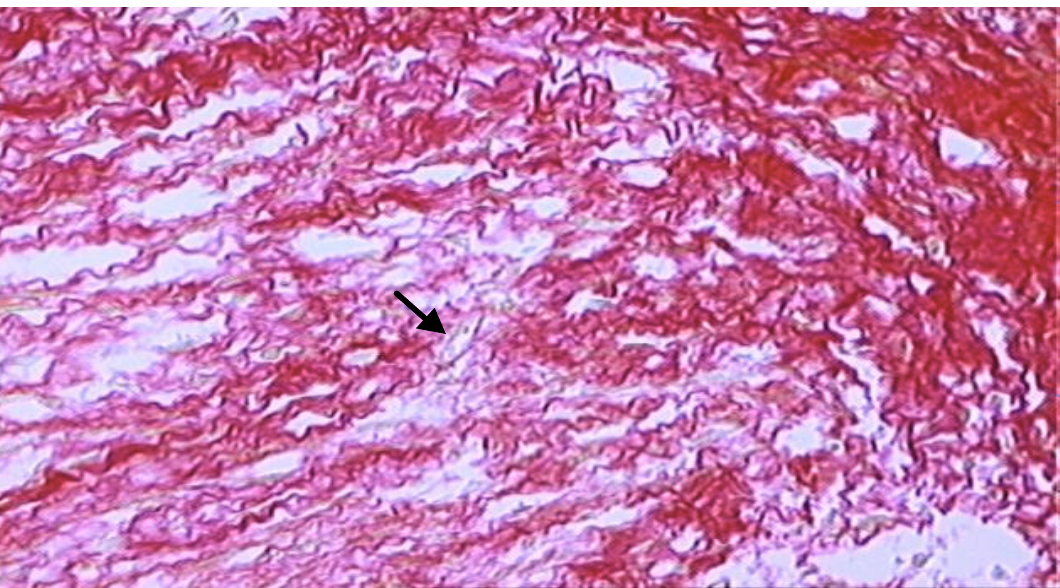
FIGURA 8 – Fotomicrografia de corte histológico da zona de anastomose jujuno-jejunal de coelho do sub-grupo Ao (adesivo sintético – 2 pontos) no 14º dia de pós- operatório. Notar a quantidade de fibras colágenas (seta). Picrosirius Red (140x).